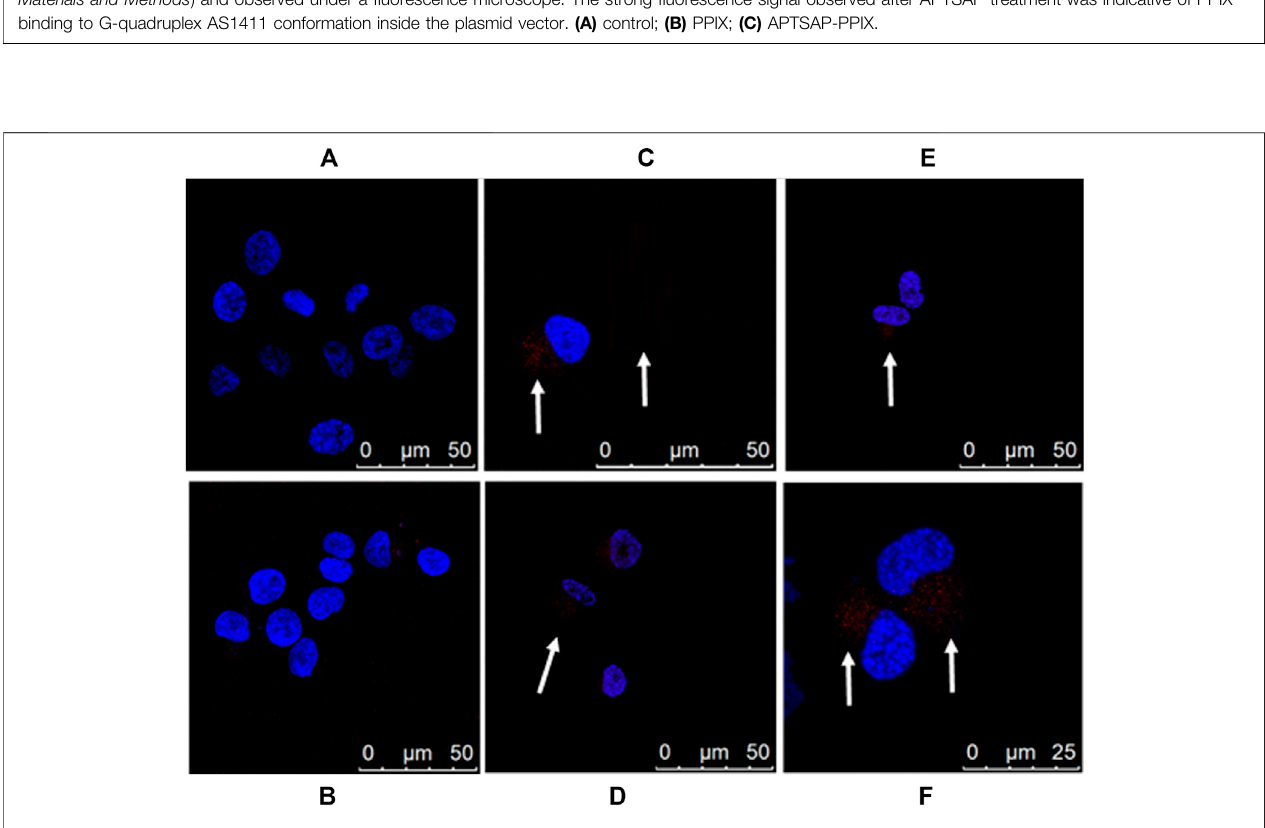
FIGURE10| ImagingofU87MGcellsbyAPTSAP-protoporphyrinIX.U87MGcellswereincubatedfor2 hwith5 µMAPTSAP-PPIXcomplexesand5 µMPPIXand observed under a confocal microscope. (A) control; (B) PPIX; (C – F) APTSAP-PPIX.